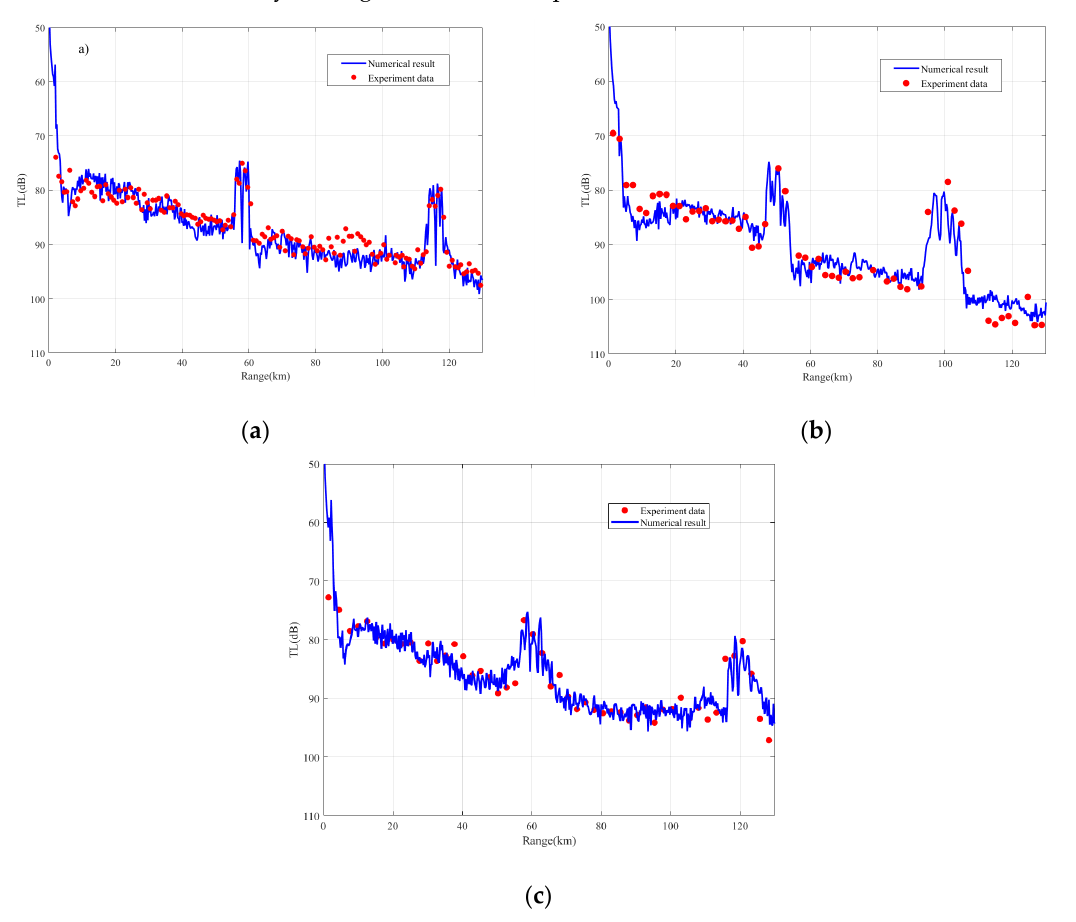
Figure 6. Comparison of the experimental and numerical TLs ( a ) For the propagation track of EIO 2019 at the receiving depth of 255 m; ( b ) for the propagation track of SCS 2018 at the receiving depth of 255 m; ( c ) for the propagation track of EIO 2021 at the receiving depth of 285 m.